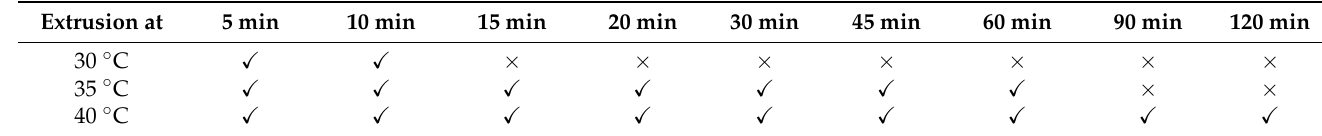
Table 3. Extrudability of printing ink at different temperatures.